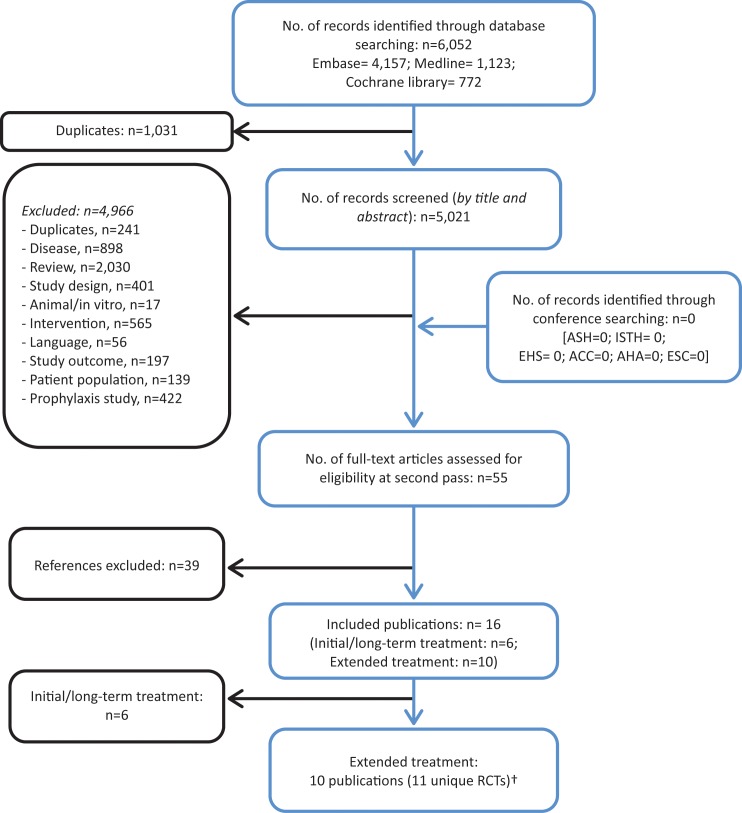
Systematic review flow diagram.The flow diagram indicates inclusion and exclusion of publications at each stage of the systematic review process. †An updated search was conducted in April 2016. No additional eligible publications were identified.